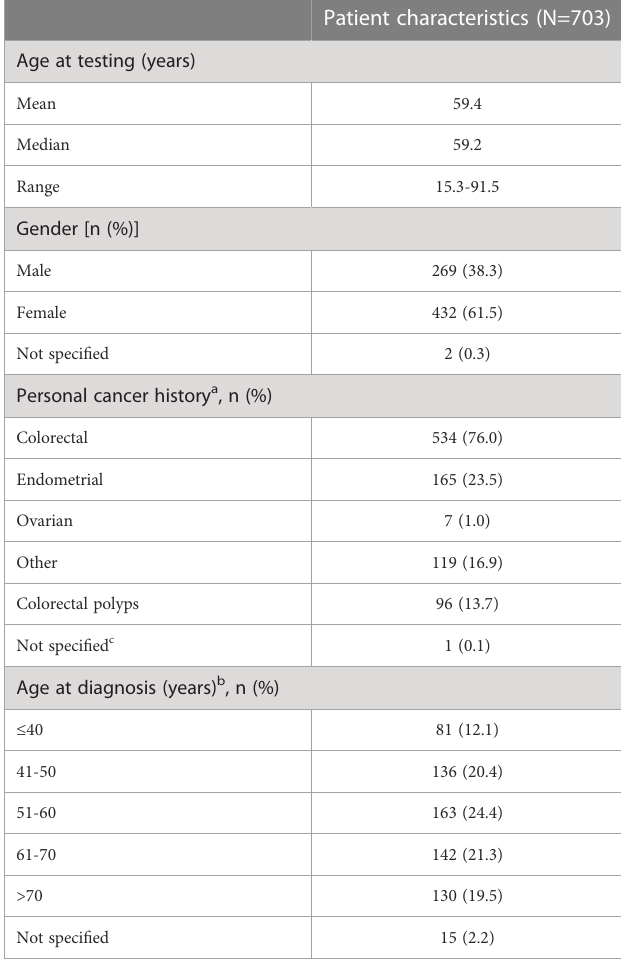
TABLE 1 Characteristics of the testing